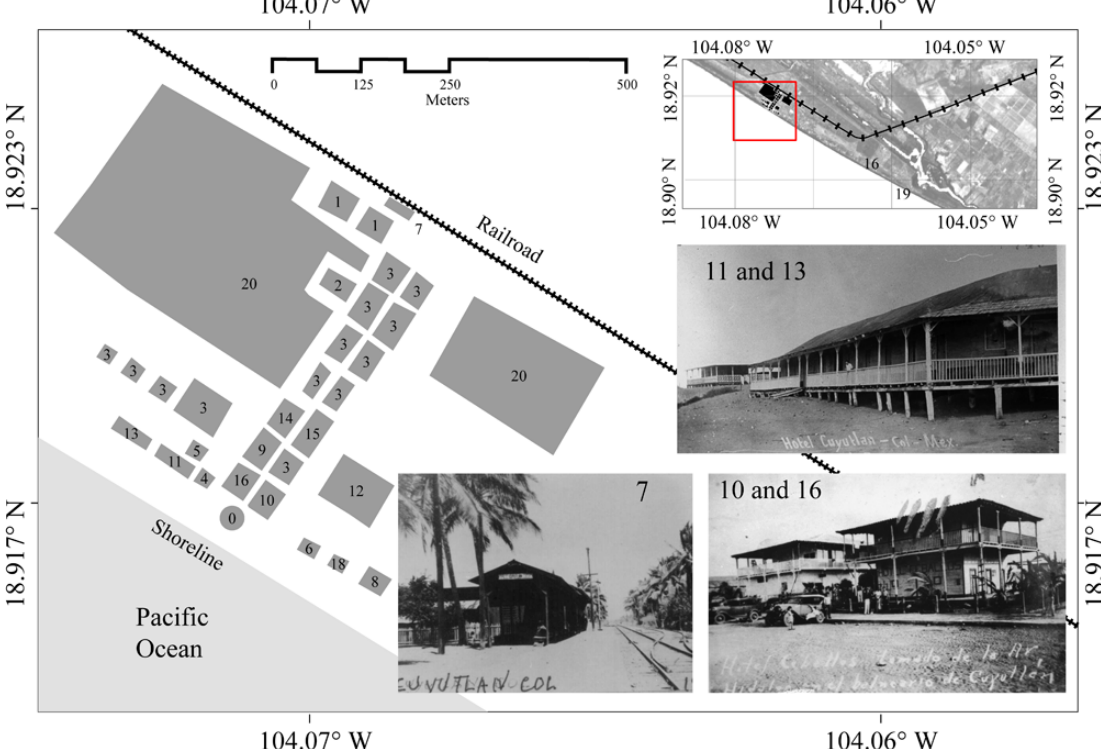
Fig. 5. Planimetric map of Cuyutl´an in 1932. (0) Old stone roundabout, (1) Salt warehouse, (2) Little church, (3) private little houses, (4) Aguayos’s Chalet, (5) Solorzano’s Chalet, (6) Wattles, (7) Train station, (8–9) Hotels nameless, (10) Hotel Ceballos, (11) Hotel Cuyutl´an, (12) Hotel Madrid, (13) Hotel Palacios, (14) Hotel Santa Cruz #1, (15) Hotel Santa Cruz #2, (16) Hotel Zapotlan, (17) Orde˜na Anguiano, (18) Hostal, (19) Palo Verde Ranch and (20) Housing